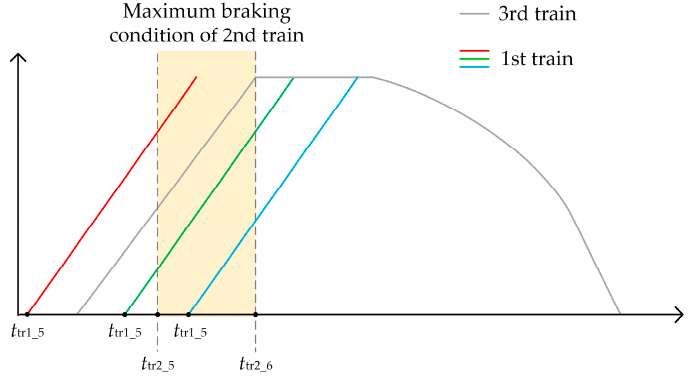
Figure 7. The traction curves of the 1st train when the 3rd train operates in four-mode operation. The colored lines are the different traction curves for the 1st train. The silver curve is the driving curve for the 3rd train. The orange background is the period that the 2nd train operates in maximum braking condition. The t tr1_5 equals to the travel time from Station A to Station B plus dwell time at Station B ( T A + T DB ). There are four situations for the 1st train to use the regenerative braking energy produced by the 2nd train. Define the t tr1_start and t tr1_end to be the start time and end time for the 1st train to use the regenerative energy. The 2nd train’s switching points are chosen for discussion.